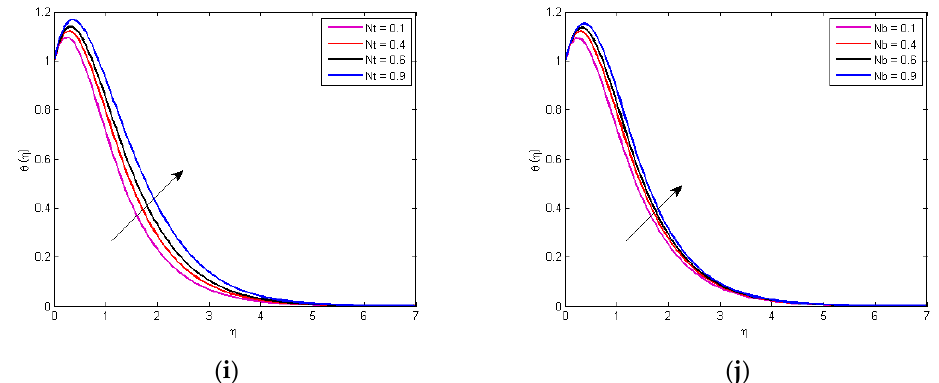
( j ) β φ α , ( b ) is , ( c ) is , ( d ) is 0 1